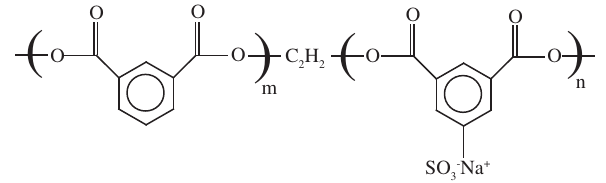
Figure 1. Chemical structure of PES.